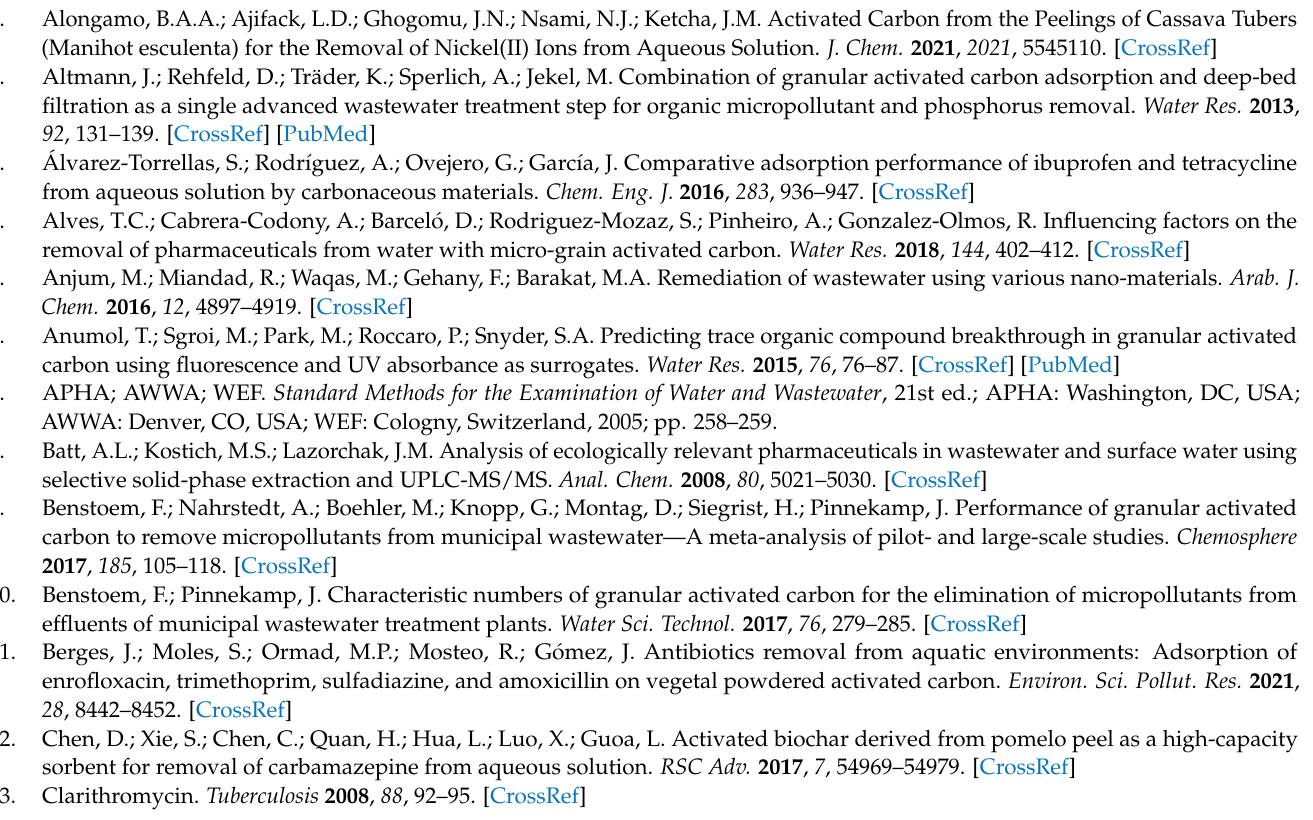
correlation; Table S2: Analysis of variance for the fitted models; Table S3: Optimization results of possible